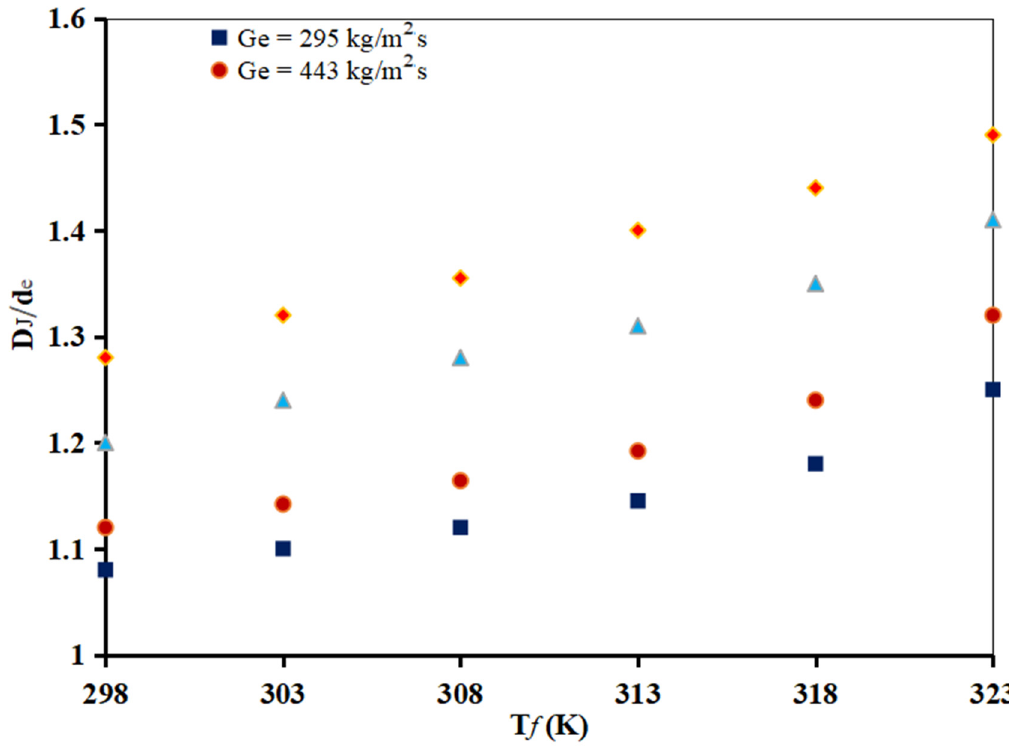
Figure 4. Correlations with the present data for dimensionless steam jet length for the steam mass flux of Ge = 672 kg/m 2 s.